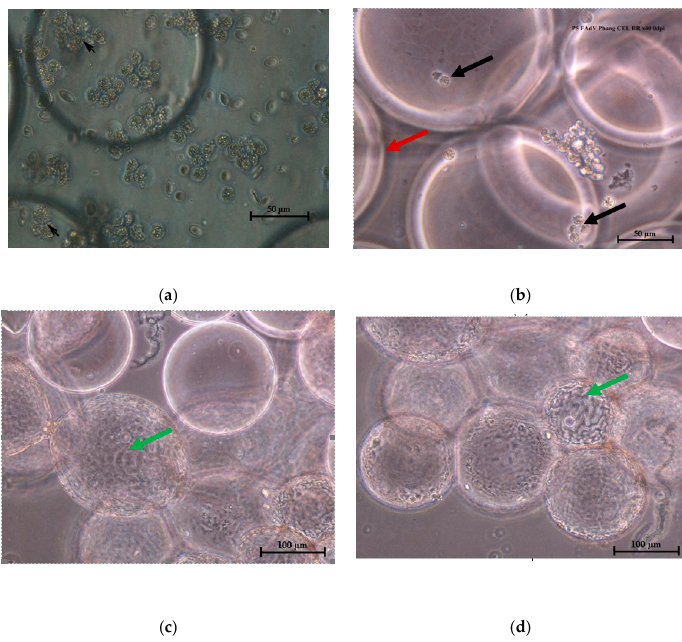
Figure 1. Inverted microscopic image of chicken embryo liver (CEL) cells attachment on the surface of Cytodex™ 1 microcarrier indicating adaptation of the cells to microcarrier culture. ( a , b ) CEL cells attached to Cytodex™ 1 microcarrier at 3 h of incubation. ( c , d ) CEL cells confluent on Cytodex™ 1 microcarrier beads at 24 h of incubation in bioreactor. Black arrow shows cells attached to Cytodex™ 1 microcarrier, red arrow shows normal Cytodex™ 1 microcarrier beads without any cells attached, and green arrow shows confluent Cytodex™ 1 microcarrier beads. 3.2. Propagation of FAdV in CEL Cells Adapted on Cytodex™ 1 Microcarrier Processes 2020 , 8 , x FOR PEER REVIEW The FAdV UPM08136CELP5 (Figure 2a) and UPM08136CELP20 (Figure 2c) isolates caused CPE and detachment of cells from microcarriers from 24 h post-inoculation. At 48 h, most of the cells had detached from the microcarrier beads (Figure 2b,d) indicating suitability of the Cytodex™ 1 and STB for propagation of FAdV serotype 8b.